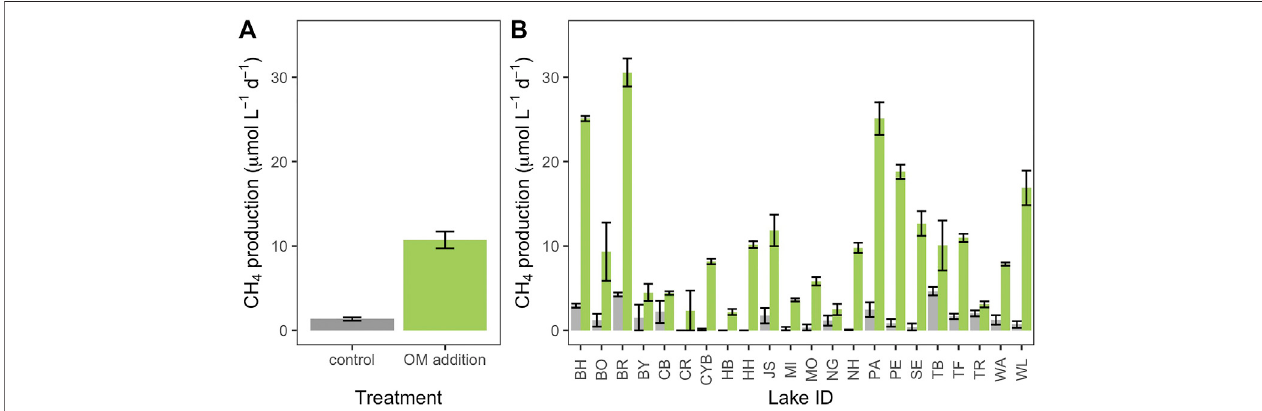
FIGURE 2 | Net methane (CH 4 ) production rates of sediment slurry incubations across organic matter (OM) additions (grey: control; green: OM addition). OM additions signi fi cantly increased the net CH 4 production rate across all lakes ( (A) ; KruskalWallis test: χ 2 = 73.2, p < 0.001). However, the magnitude of increase was variable across lakes (B) . Error bars indicate one standard error.